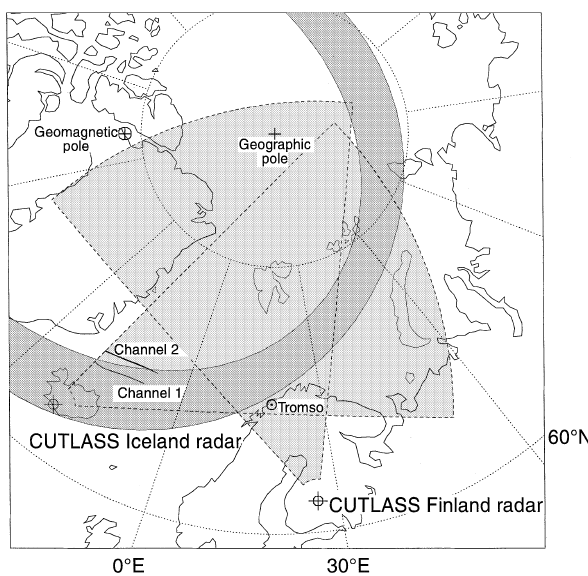
Fig. 1. The location of the fields of view of the CUTLASS Finland and Iceland radars. Also indicated is the location of the K p (cid:136) 0 auroral oval at 22 UT (Feldstein and Starkov, 1967; Holzworth and Meng,